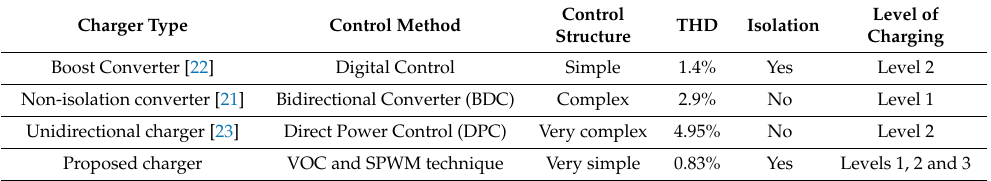
Table 4. The performance of the proposed charger compared with previous charging